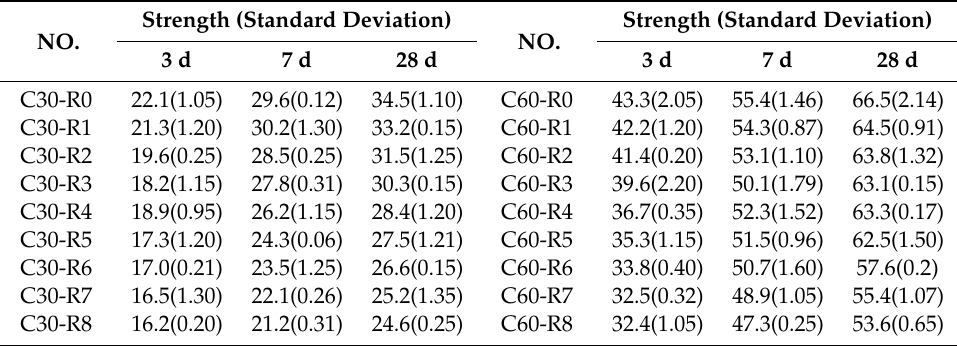
Table 7. Test results of concrete strength